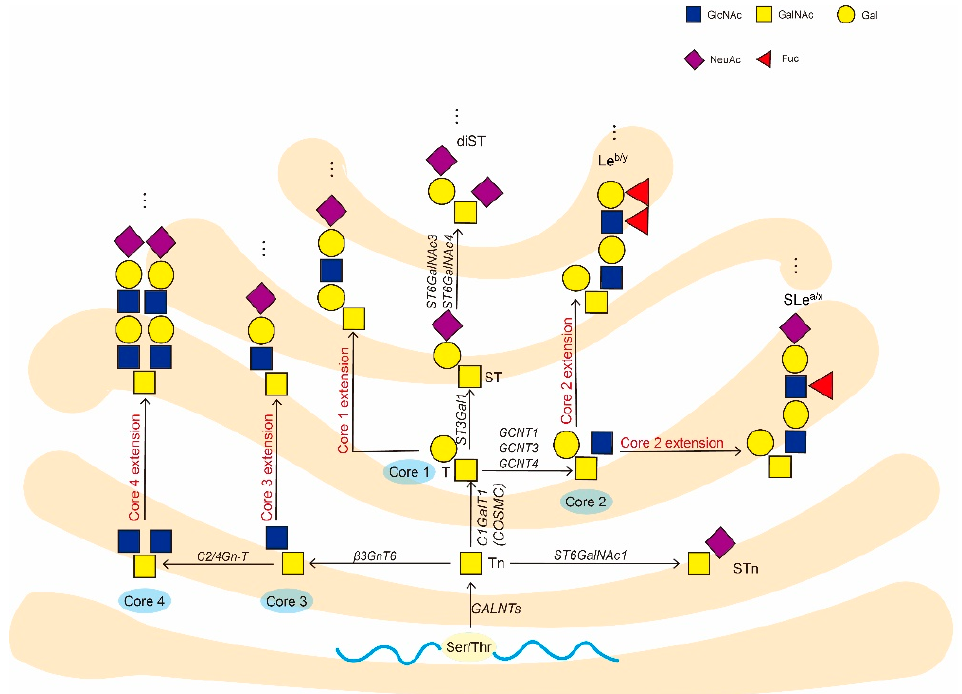
Figure 1. Biosynthesis of O-GalNAc glycans. The Ser/Thr-linked α -GalNAc O-glycan is ubiquitous in mammals and present on many different glycoproteins. The first step of O-GalNAc glycan synthesis is the linking of UDP-GalNAc to serine/threonine residues of proteins in the presence of GALNTs to form the initial structure GalNAc α 1-O-Ser/Thr (Tn antigen). Next, the Tn antigen extends to synthesize